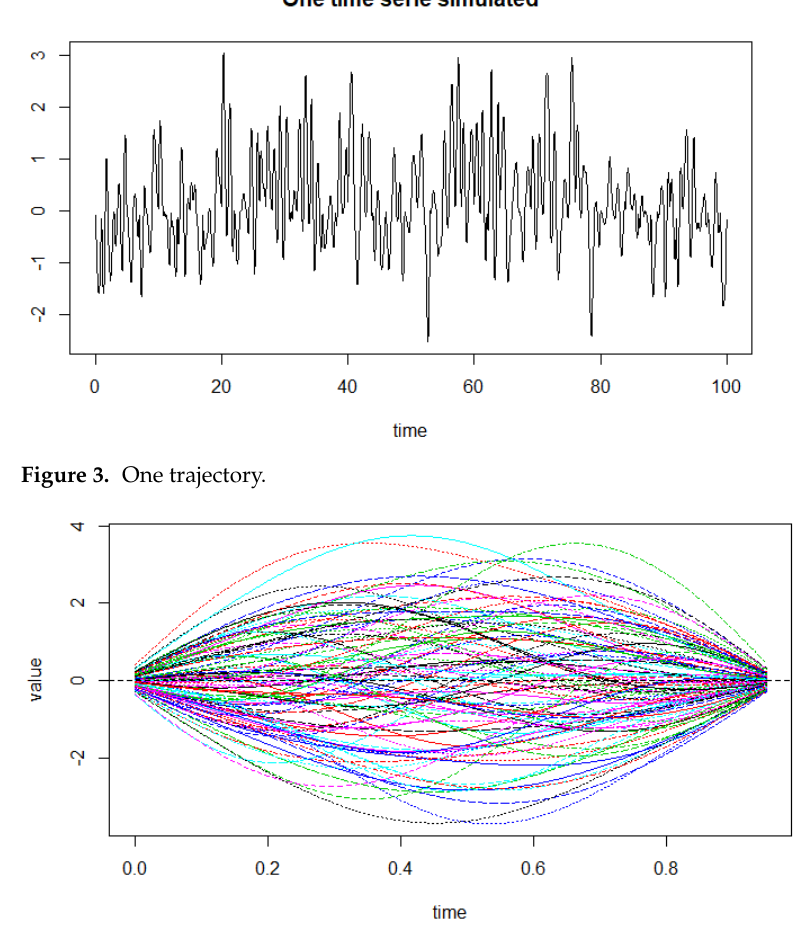
Figure 4. One trajectory on the same time